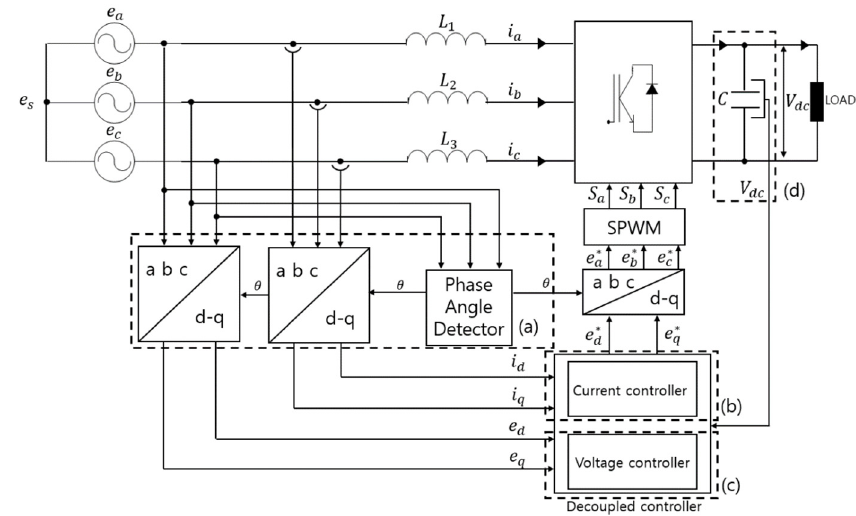
Figure 9. AC-DC hybrid distribution system of the testbed.